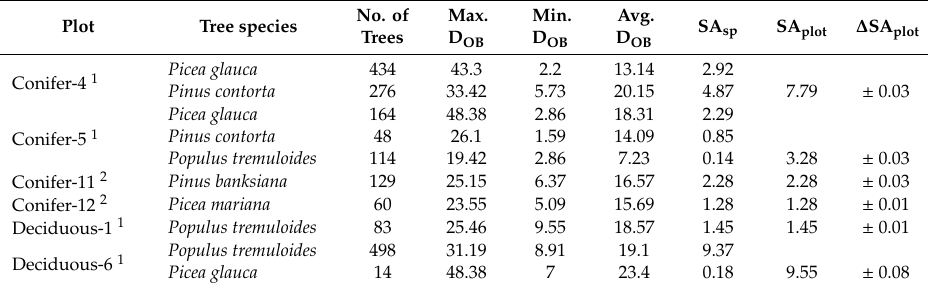
1 Indicates Sibbald region of Kananaskis Country and 2 indicates Whitecourt